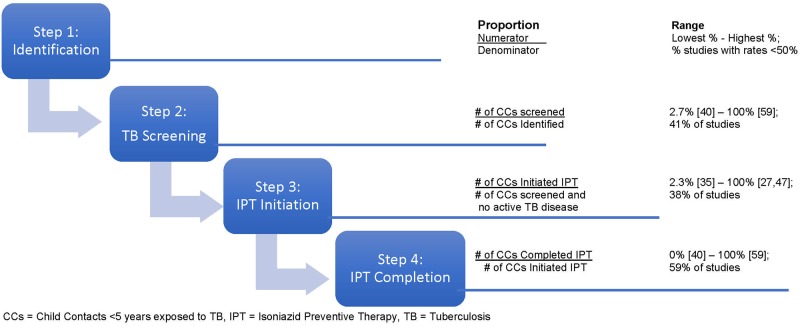
Range of proportions of child contacts completing each CCM cascade step.